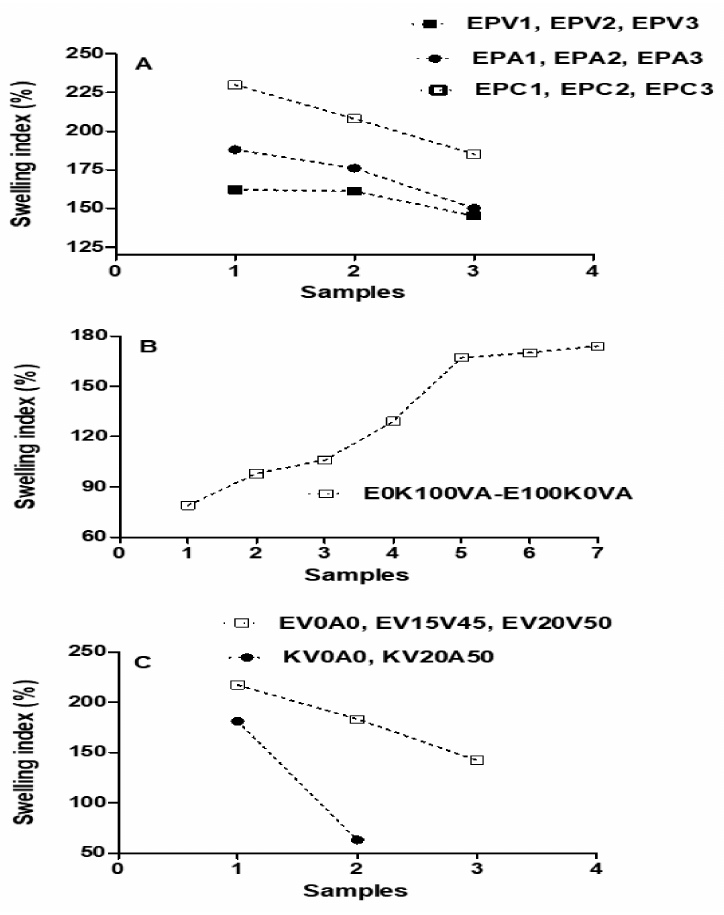
Figure 9. The swelling index of phase-1 ( A ), phase-2 ( B ), and phase-3 ( C )